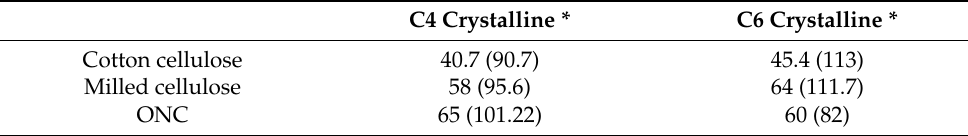
Table 3. Integral % values with respect to anomeric signals from 1 3 C NMR